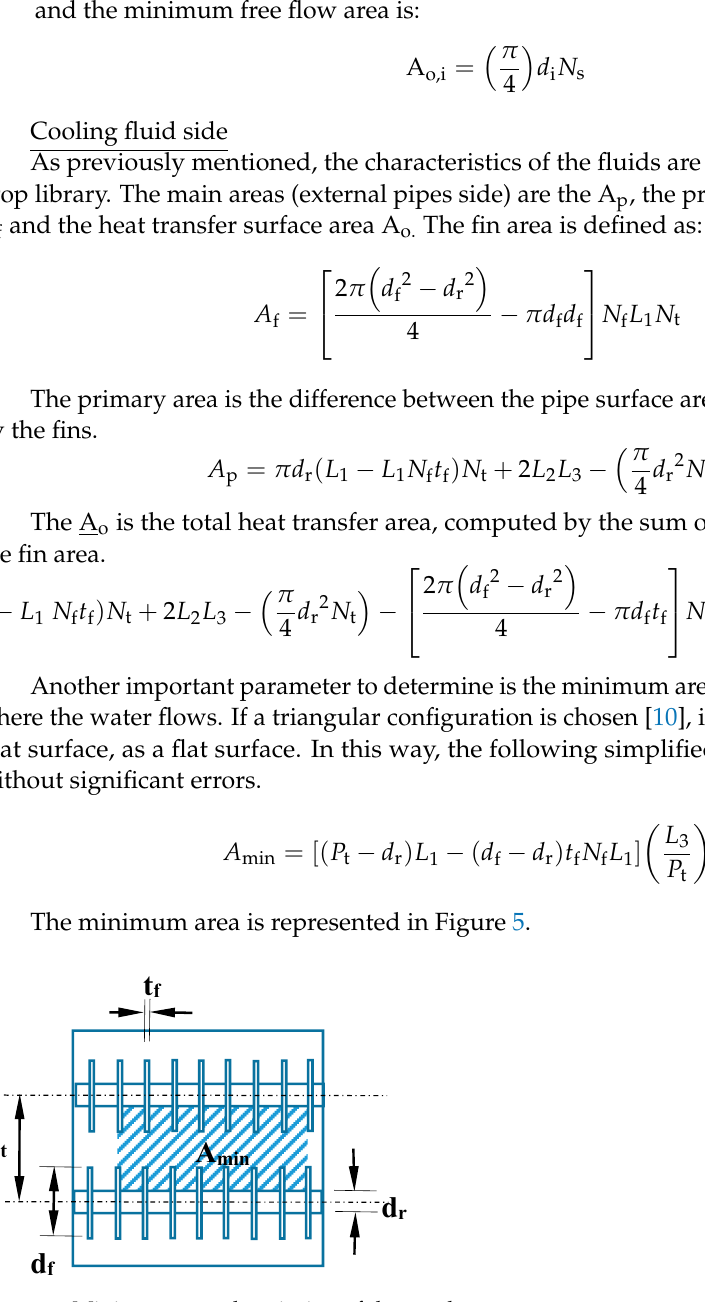
Figure 5. Minimum area description of the condenser.